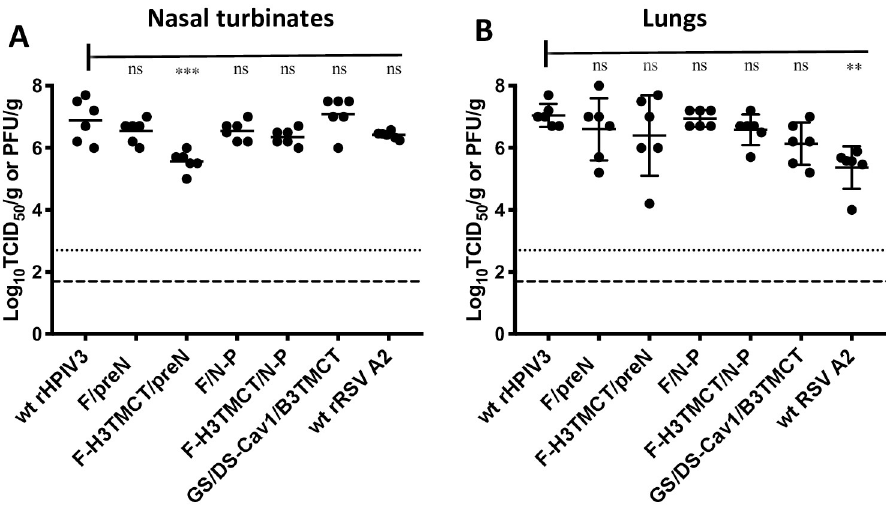
Fig 5. Replication of rHPIV3-RSV-F vectors in hamsters. Groups of 6 hamsters each were inoculated IN with 10 5 TCID 50 of each indicated rHPIV3 vector, or 10 6 PFU of wt RSV. In addition, a previously-described construct, rB/ HPIV3/GS/DS-Cav1/B3TMCT (labeled in the Figure as GS/DS-Cav1/B3TMCT) [13, 14], was included for comparison: this consists of the rB/HPIV3 vector expressing, from the second gene position, RSV F with the same codon-optimization and the same HEK, DS, and Cav1 mutations as in the present study, but with the TMCT domains from BPIV3 F protein. At day 5 post-inoculation, virus replication in the nasal turbinates (A) and lungs (B) was assessed by virus titration of tissue homogenates by TCID 50 limiting dilution assay on LLC-MK2 cells (rHPIV3 and rB/ HPIV3 vectors) or immunoplaque assay on Vero cells (wt rRSV). The virus titers for the individual hamsters are plotted as filled circles with the group mean titer indicated by a horizontal line. The limits of detection were 2.2 log 10 TCID 50 /gram for the rHPIV3 and rB/HPIV3 vectors and 1.7 log 10 PFU/gram for RSV (indicated by dotted and dashed lines, respectively). The statistical significance of the difference between the empty vector and the other viruses was determined by one-way analysis of variance with Tukey’s multiple-comparisons post-test and is indicated by ��� (P < 0.001) and ns (not significant; P > 0.05).